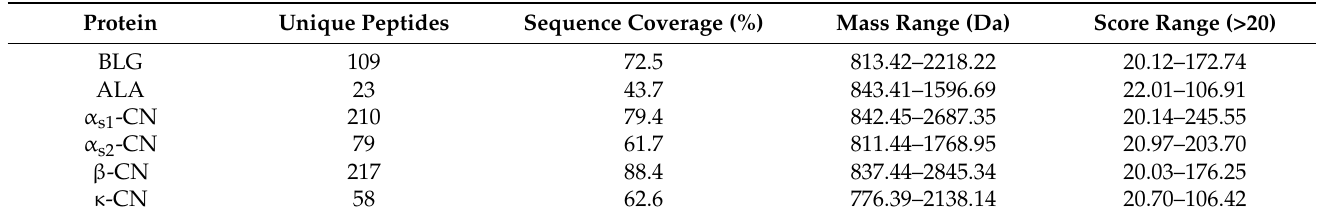
Table 1. The protein profile (score ≥ 20) of digested products characterized by liquid chromatography– mass spectrometry. CN, casein. BLG, β -lactoglobulin. ALA, α -lactalebumin.